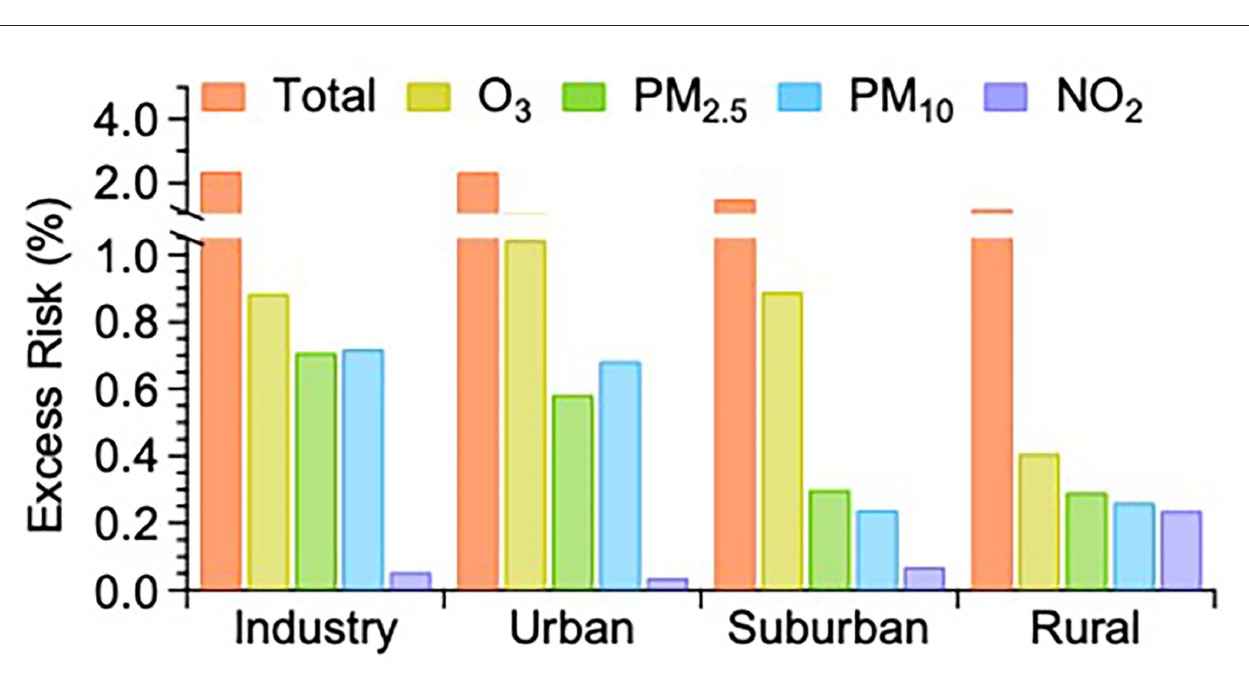
FIGURE5 The comparison of excess risks (ERs) averaged over 2017 and 2018 attributable to the sum and individual air pollutants among the four functional areas in Jining.